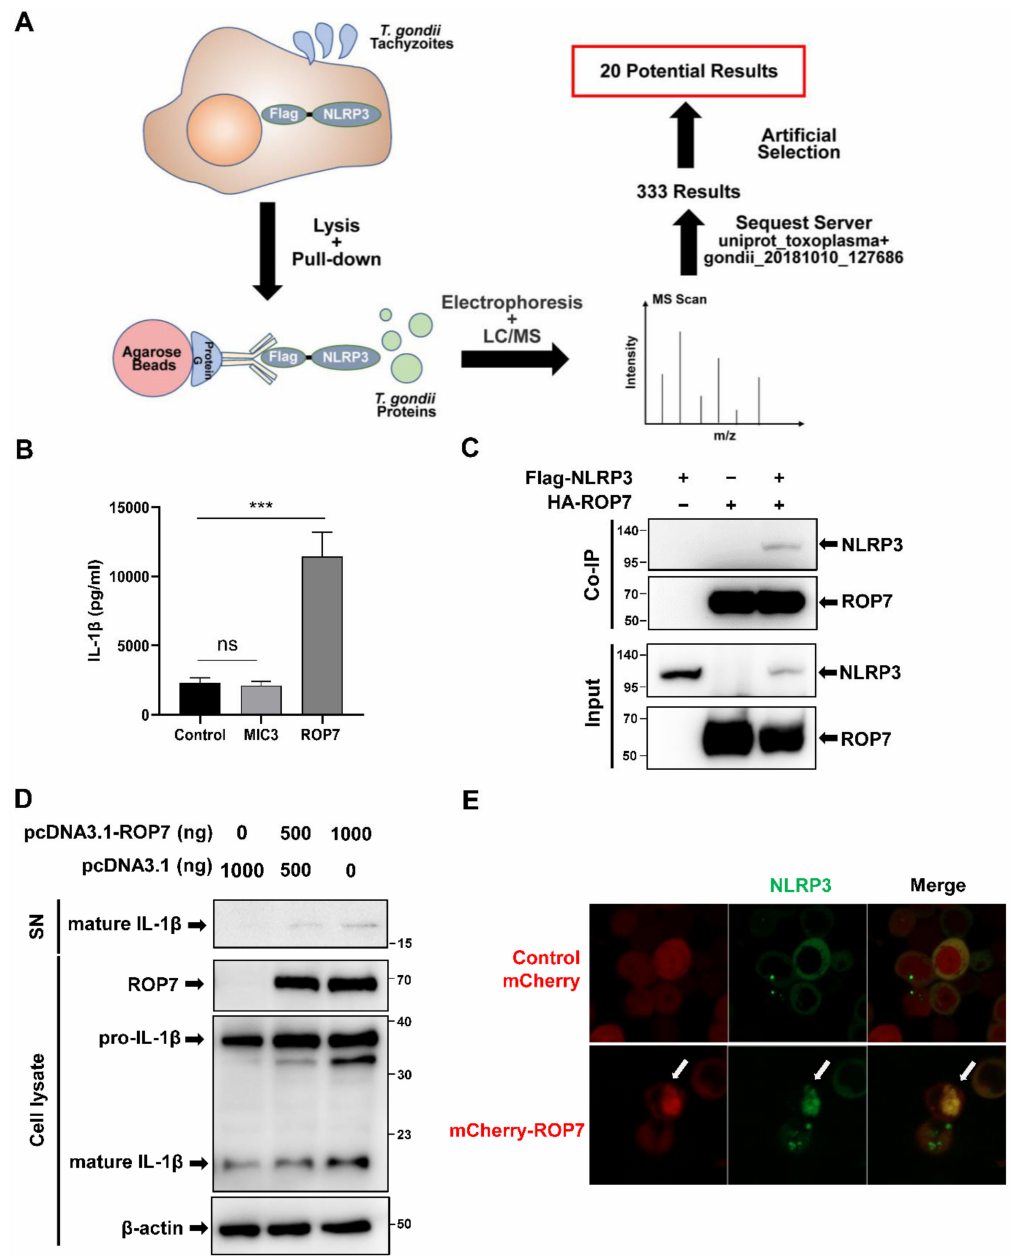
Figure 1. ROP7 is associated with NLRP3 and promotes the maturation of IL-1 β in 293T cells. ( A ) Schematic for the identification of potential proteins interacting with NLRP3. Protein G binding with anti-Flag-precipitated parasite proteins from 293T cell lysates following parasite invasion. Immunoprecipitated proteins were separated by SDS-PAGE and further analyzed by LC/MS after elution. Parasite proteins were identified using a T. gondii database from Uniprot. ( B ) The 293T cells were co-transfected with inflammasome-component plasmids (pro-IL-1 β , pro-caspase-1, NLRP3, and ASC) and ROP7, MIC3, or an empty vector. The IL-1 β secretion in cell-free supernatant was measured after 36 h. Data are expressed as mean ± SEM values. ns: non-significant, *** p < 0.001,